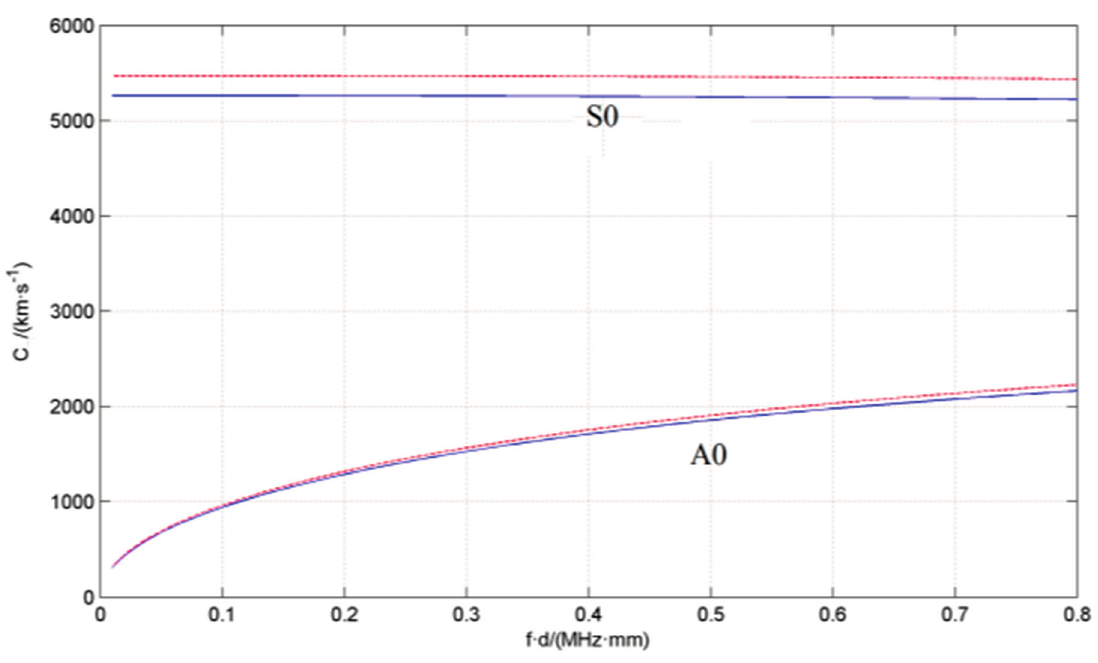
Figure 7. Dispersion curve of the experimental plates (A0: flexural mode, S0: extensional mode; Solid line: 302 steel, Dotted line: magnesium aluminum alloy).